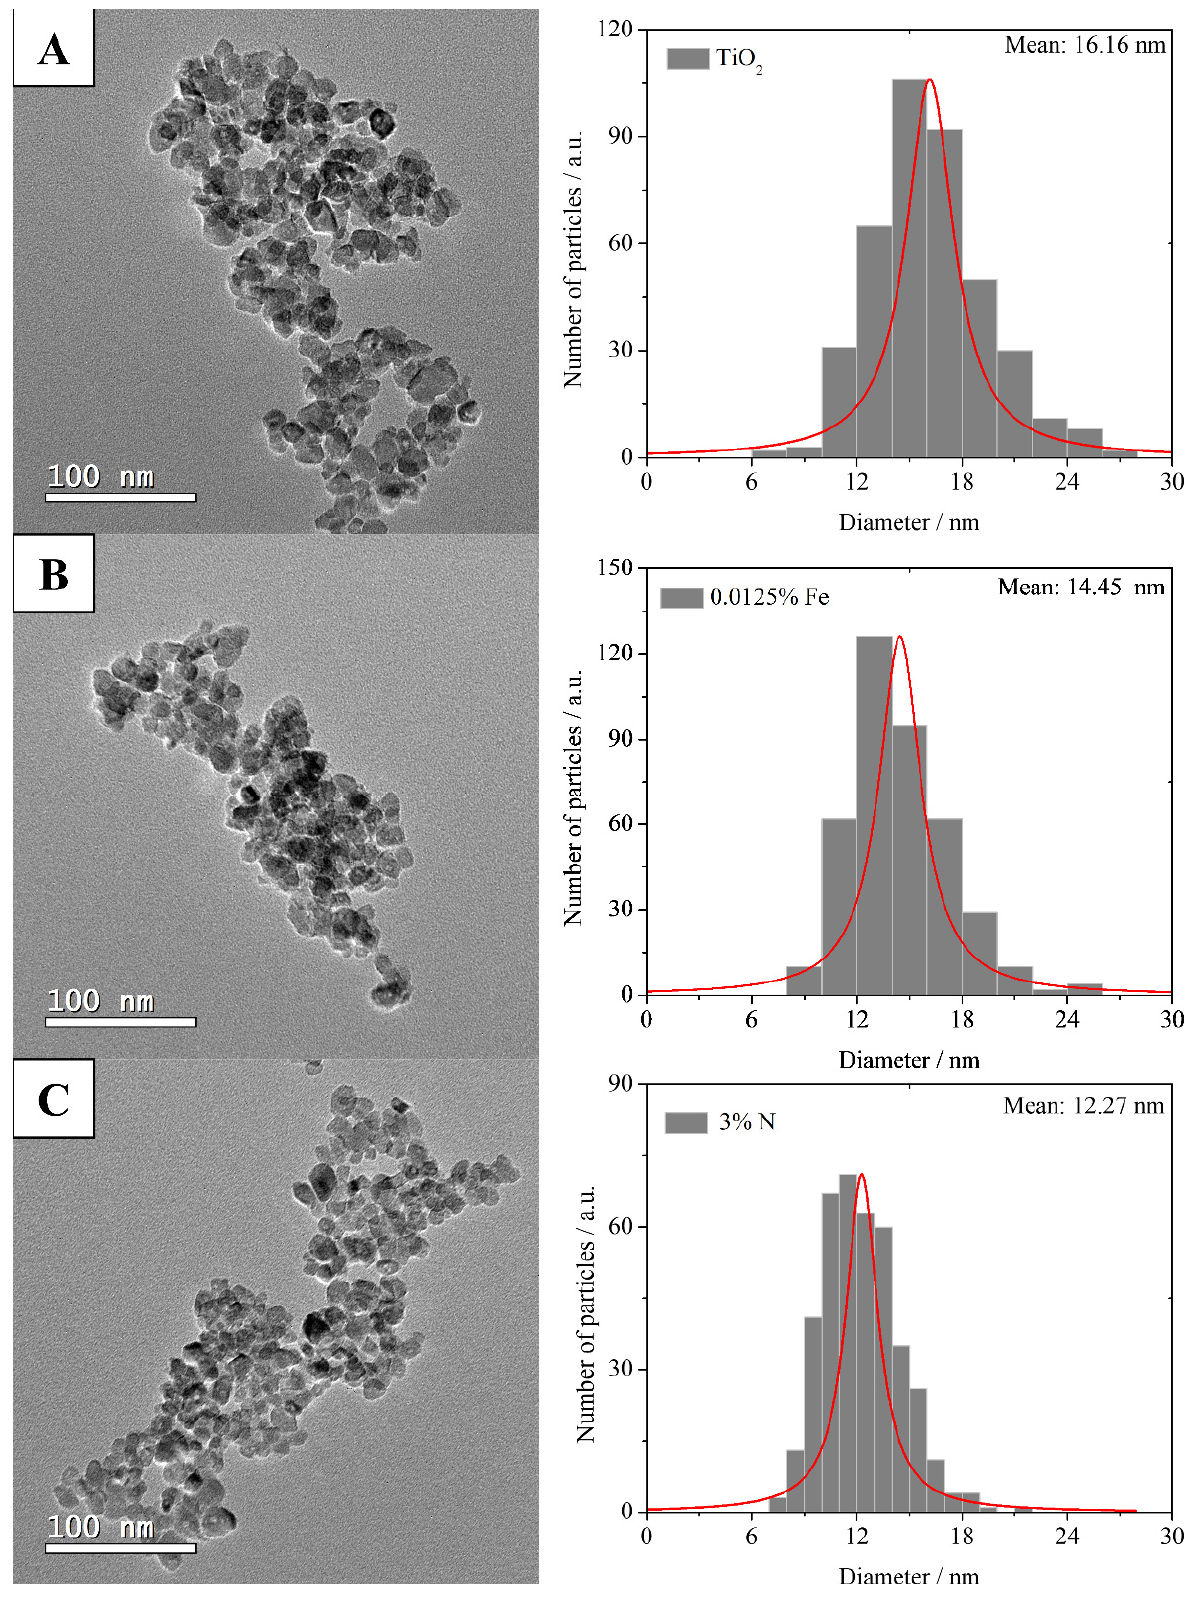
Figure 4. TEM images and their size distributions of particles ( A ) TiO 2 , ( B ) 0.0125% Fe, and ( C ) 3% N.